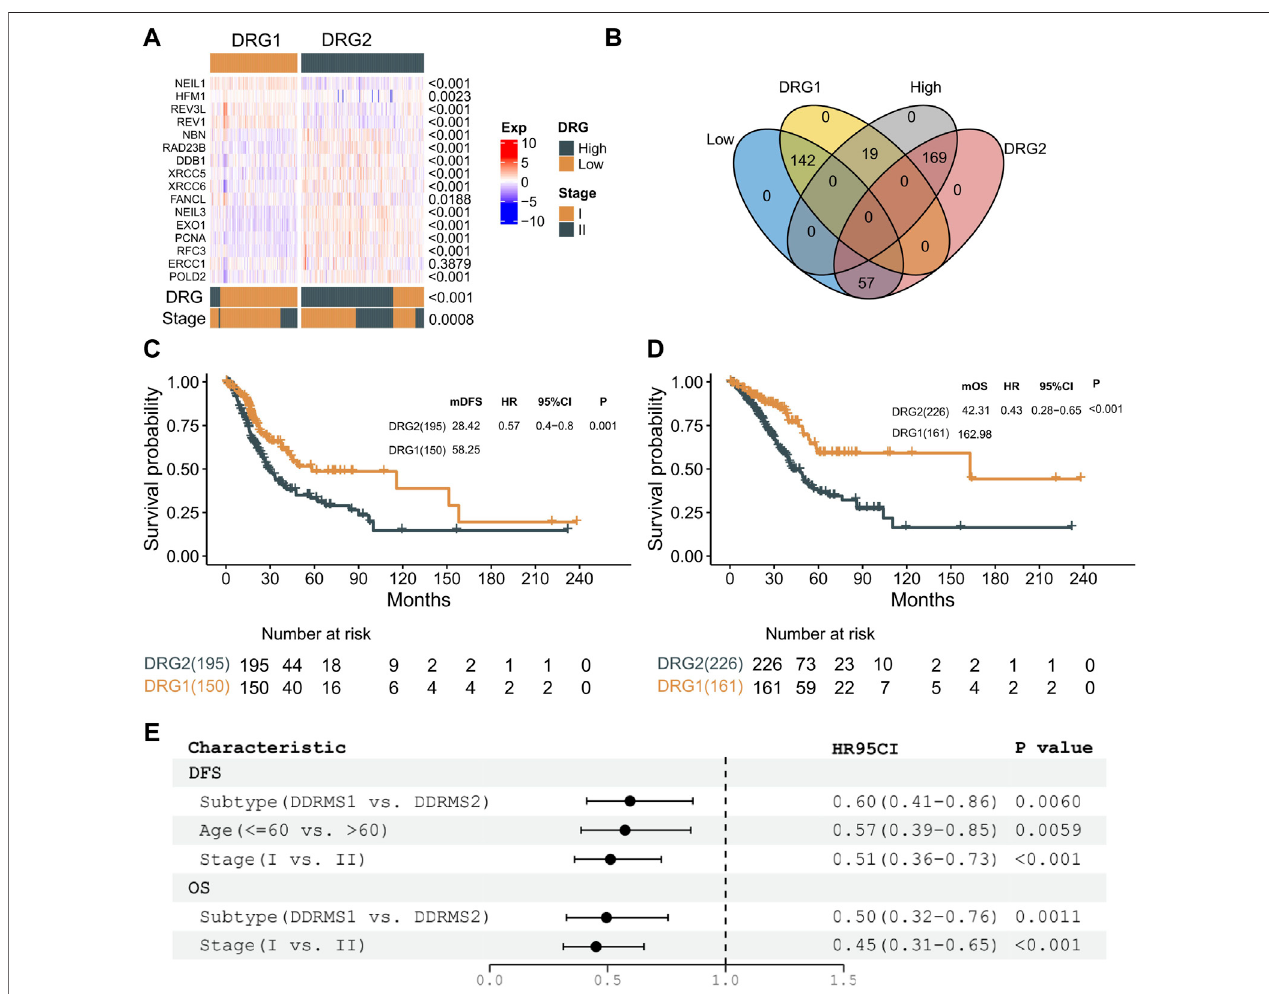
FIGURE 3 | Molecular subtype identi fi cation. (A) Expression pro fi les of 16 genes between DRG1 and DRG2 in the stages I and II TCGA – LAUD dataset. p -value of continuous variables was tested using the Wilcoxon rank-sum test. The consistency of DRG and molecular subtype was tested using the Kappa consistency test. Pearson ’ s chi-square test was used to test the categorical variables. (B) Venn plot presenting the intersection of patient share by molecular subtype and DRG. (C) Kaplan – Meier curves showing DFS between DRG1 (yellow) and DRG2 (gray) in patients with early-stage LUAD. (D) Kaplan – Meier curves showing OS between DRG1 (yellow) and DRG2 (gray) in patients with early-stage LUAD. (E) Multivariable analysis of DFS and OS with a Cox proportional hazards model in early-stage lung carcinoma.